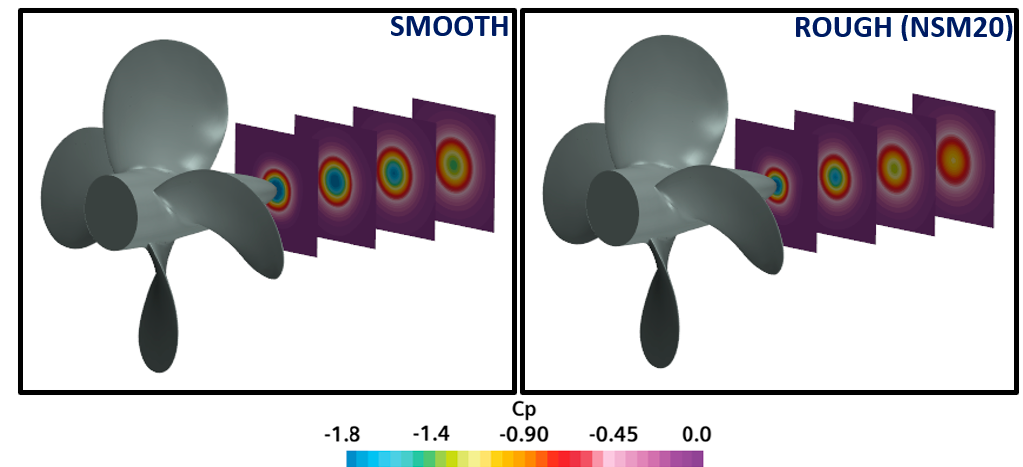
Figure 11. Change in non-dimensional pressure distribution with roughness. J. Mar. Sci. Eng. 2022 , 10 , 1426